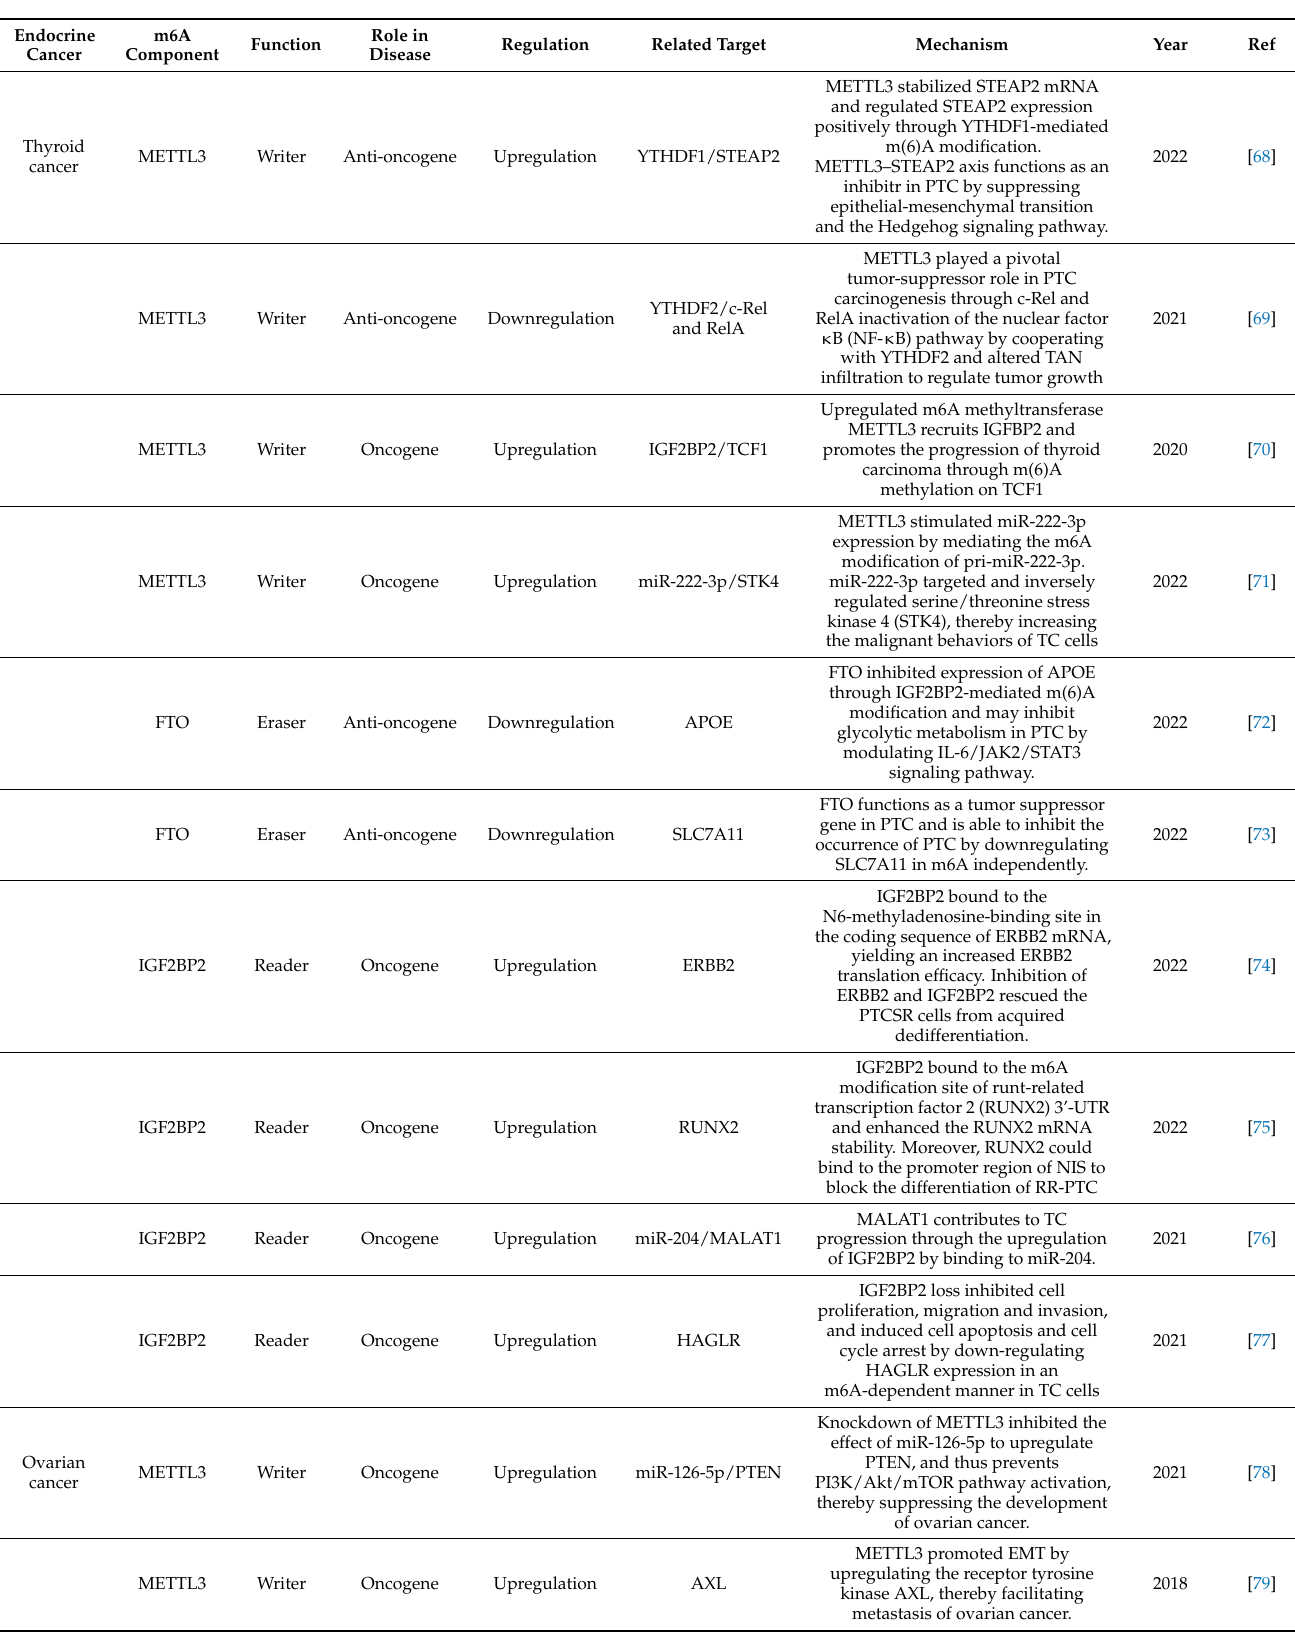
Table 1. The roles of m6A enzymes in endocrine cancer